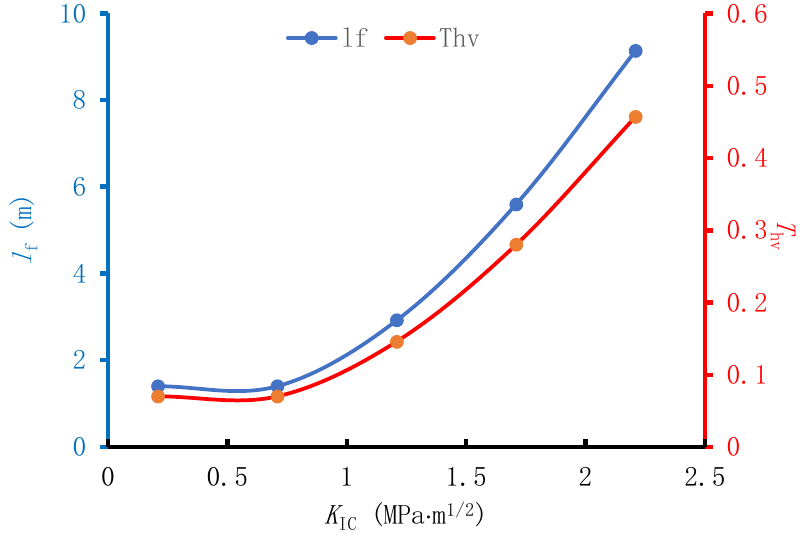
Figure 8. The length of horizontal fracture and the morphology of T-type fracture change with fracture toughness of coal.